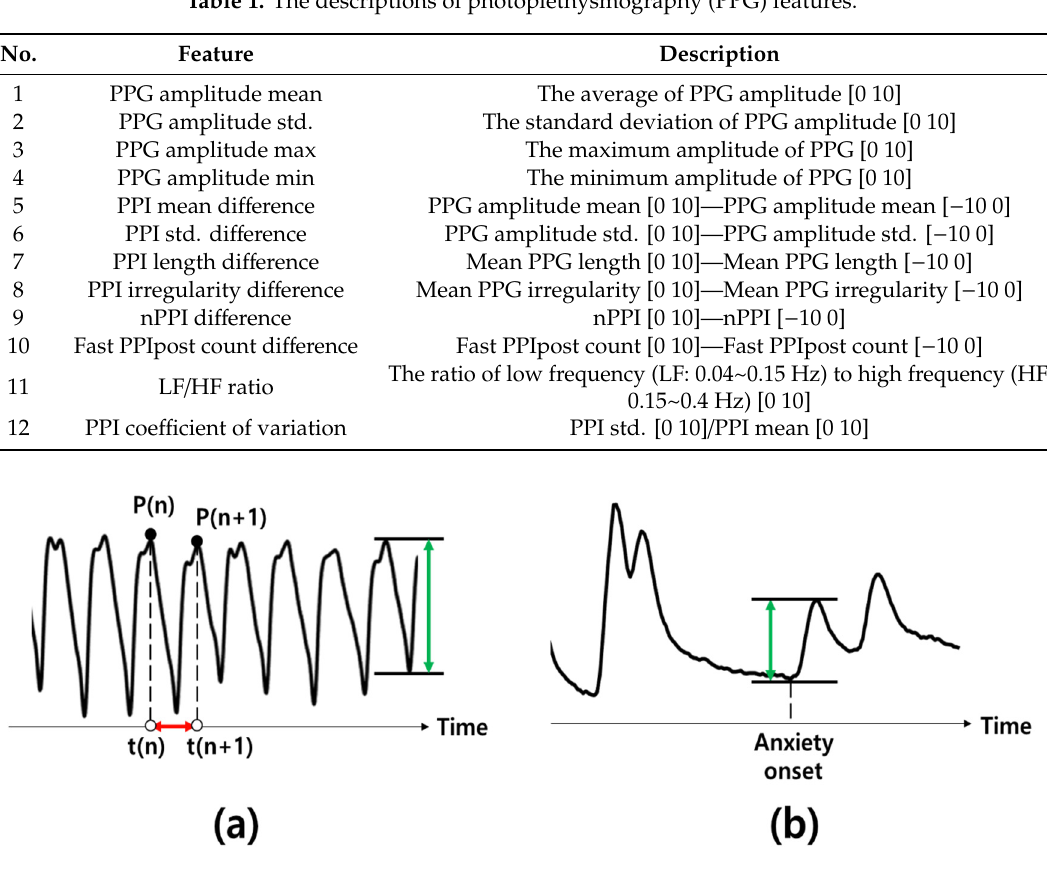
Figure 3. Examples of photoplethysmography (PPG) and electrodermal activity (EDA) signals from subject 1. ( a ) The description of peak-to-peak interval (PPI) (red) and PPG amplitude (green). ( b ) The description of EDA amplitude. Table 1. The descriptions of photoplethysmography (PPG)